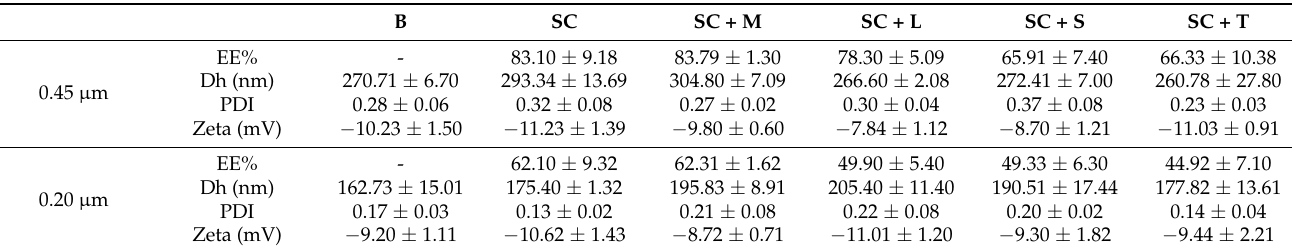
Figure 1. Influence of lyoprotectants on the viscosity of liposome suspensions (SC: sildenafil citrate liposomes without additive; SC + M: sildenafil citrate liposomes with mannitol; SC + L: sildenafil citrate liposomes with lactose; SC + S: sildenafil citrate liposomes with sucrose; SC + T: sildenafil citrate liposomes with trehalose). Table 1. Influence of additives on the characteristics of fresh liposomes. EE, Dh, PDI, and Zeta: entrapment efficiency, size, polydispersity index, and zeta potential,